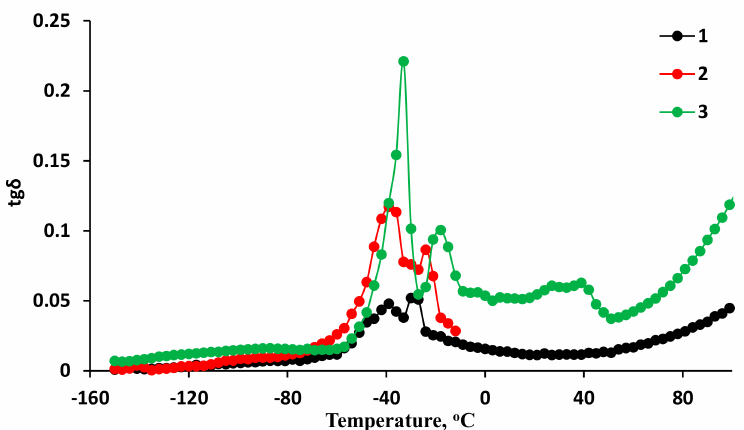
Figure 10. Temperature dependences of the dielectric loss tangent of polymers based on [PPEG]:[TDI] = 1:12 (1) and [PPEG]:[D 4 ]:[TDI] = 1:2:12 obtained in the presence of [ASiP] = 0 wt% (2), 0.2 wt%